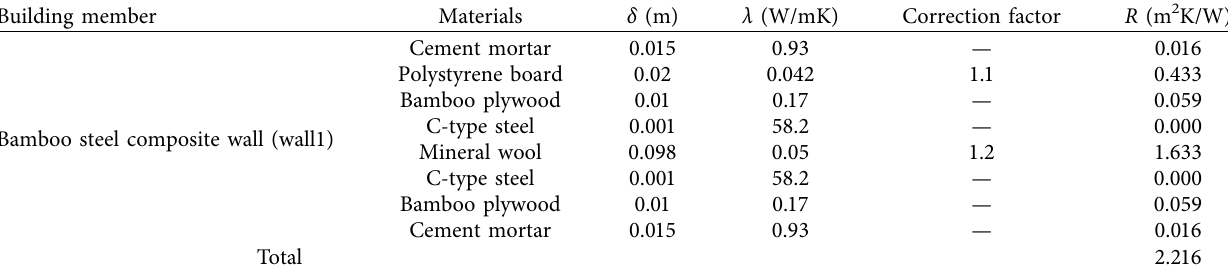
Table 4: Calculative processes of thermal resistance.